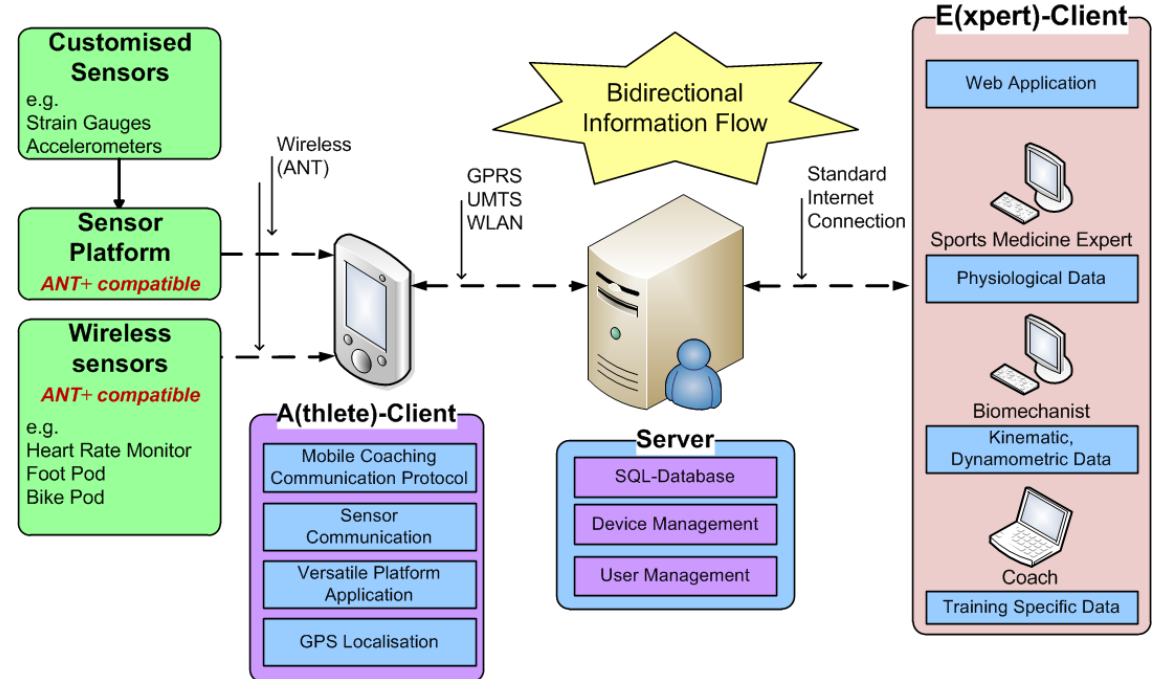
Figure 1. Framework of the server-based Mobile Coaching